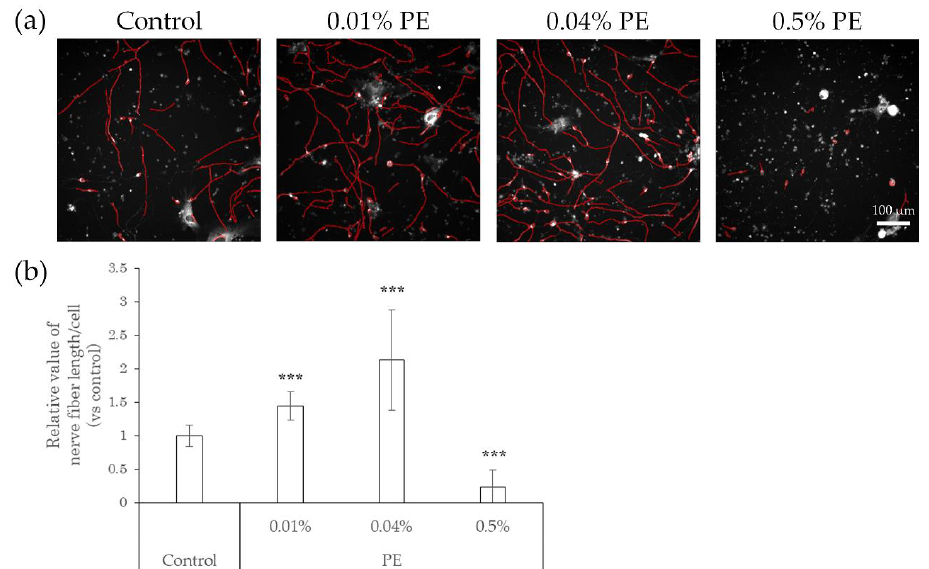
Figure 4. Effects of direct action of PE on nerve fiber elongation of hiPSC-SNs. After culturing for 3 days, hiPSC-SNs were incubated with medium containing methylparaben for 24 h and stained with NeuO. ( a ) Representative images with nerve fibers outlined in red were obtained using IN Cell Analyzer 2200. The red lines indicate NeuO-stained nerve fibers. ( b ) Nerve fiber length per cell versus the control after incubation with various doses of PE. Each value represents the mean ± standard deviation of 7–25 wells. *** p < 0.001, vs. the control (Steel’s test). PE: phenoxyethanol. Compared with control neurons, neurons exposed to BaP showed a slight but not significant increase in nerve fiber length when exposed to 0.5 µ M BaP, which is the probable concentration in the skin, as indicated in previous studies [19,20], and a slight but not Int. J. Mol. Sci. 2021 , 22 , x FOR PEER REVIEW significant decrease at concentrations of 3 µ M and 18 µ M (Figure 5).